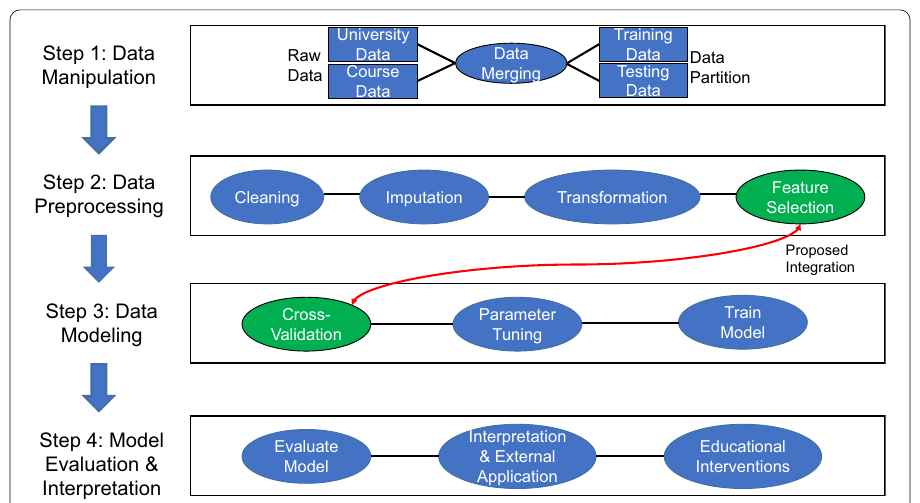
Fig. 1 Overview of a standard data science pipeline and proposed integration of feature selection with